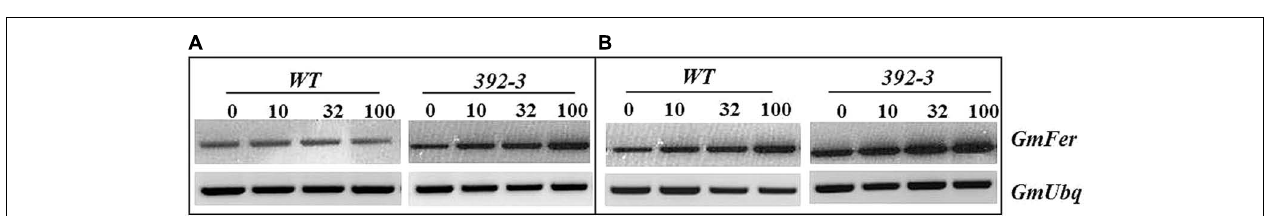
FIGURE 5 | Semi-quantitative RT-PCR analysis of the soybean ferritin ( GmFer ) expression in roots (PanelA) and shoots (Panel B) ofWT and 392-3 G. max plants grown under different iron concentrations [0, 10, 32, or 100 μ M Fe (III)-EDDHA]. Soybean ubiquitin gene ( GmUbq ) was used as template loading control.